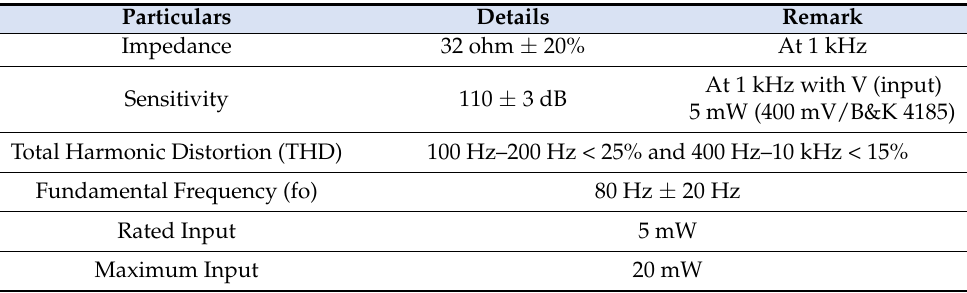
Table 1. Specification of microspeaker DSH 742–005.